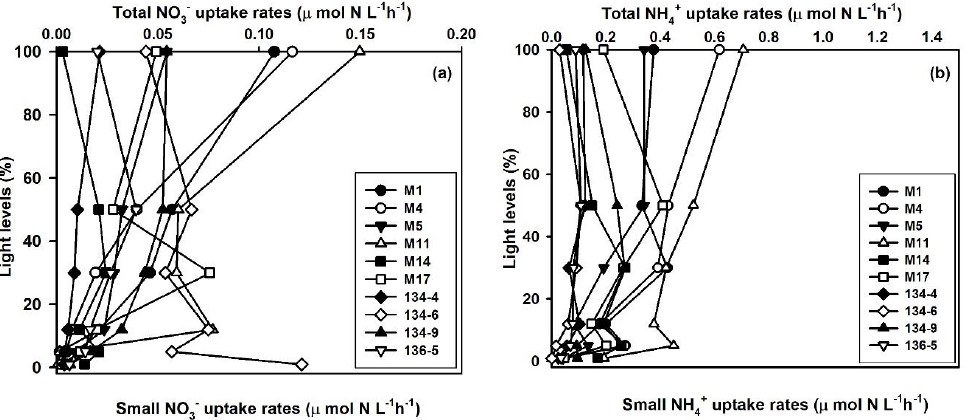
Figure 3. Depth profiles of total ( a ) NO 3 − and ( b ) NH 4 + uptake rates in the East / Japan Sea during 2012.